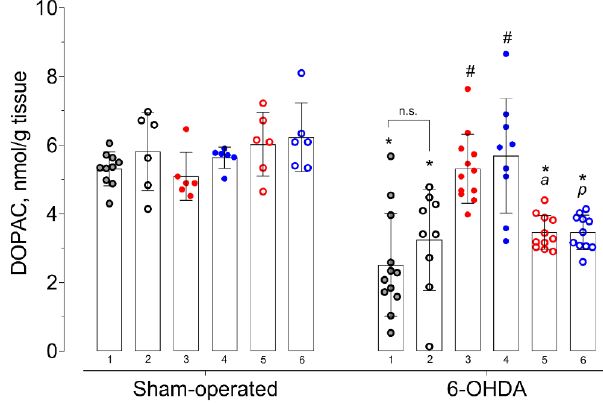
Figure 2. Influence of deferred administration of afobazole over 14 days on DOPAC content